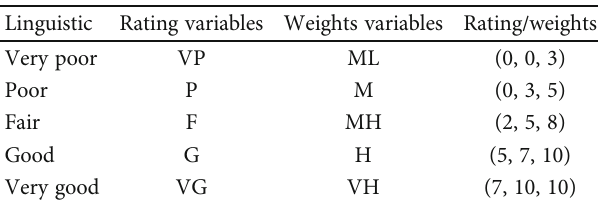
Table 3: The scale for assigning ratings for O-dimensions and weights for